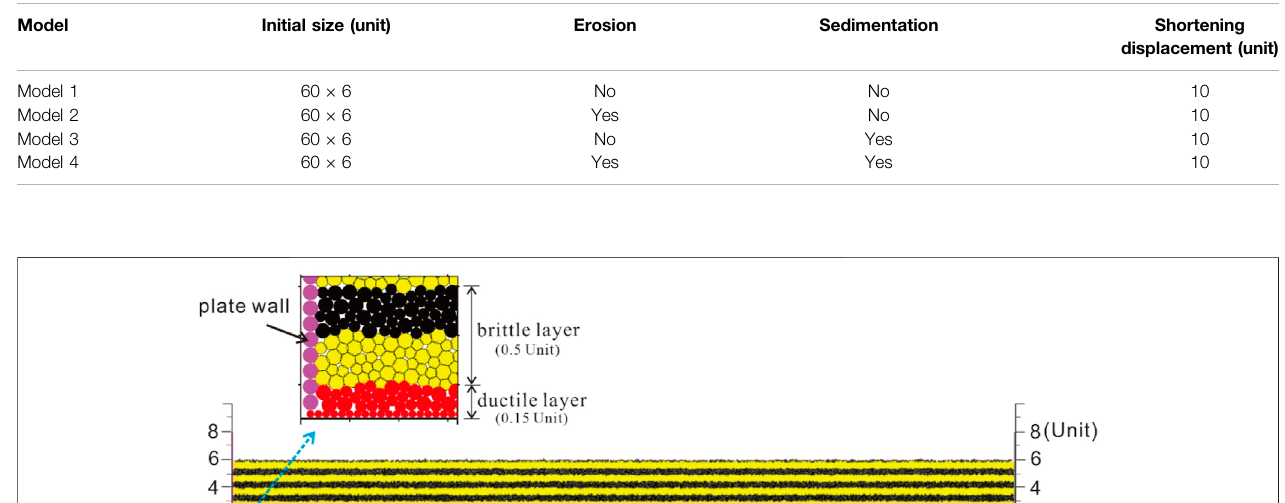
TABLE 1 | Boundary conditions of the four DEM models in this study.